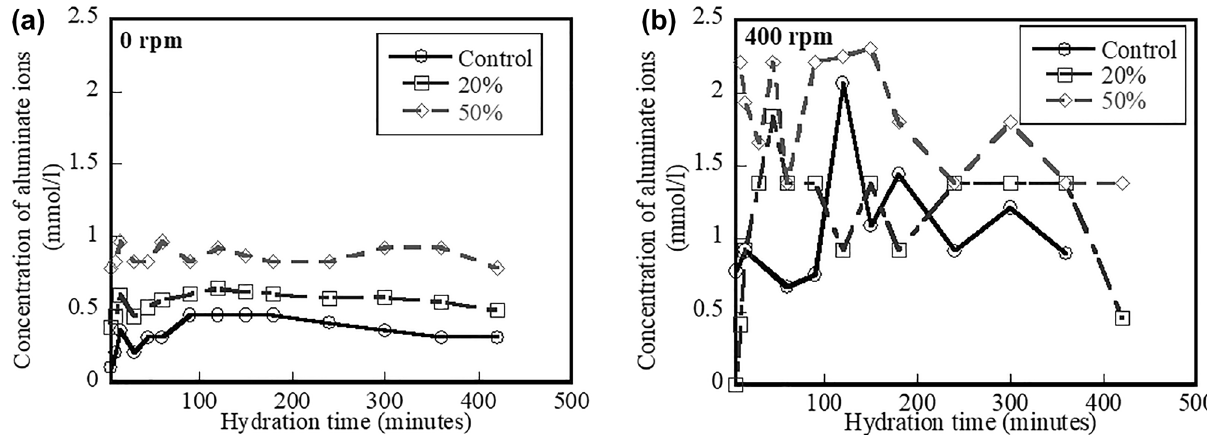
Figure 3. Effect of hydration time on aluminate ion concentration mixed at ( a ) 0 rpm and ( b ) 400 rpm of control system and systems containing 20% and 50% fly